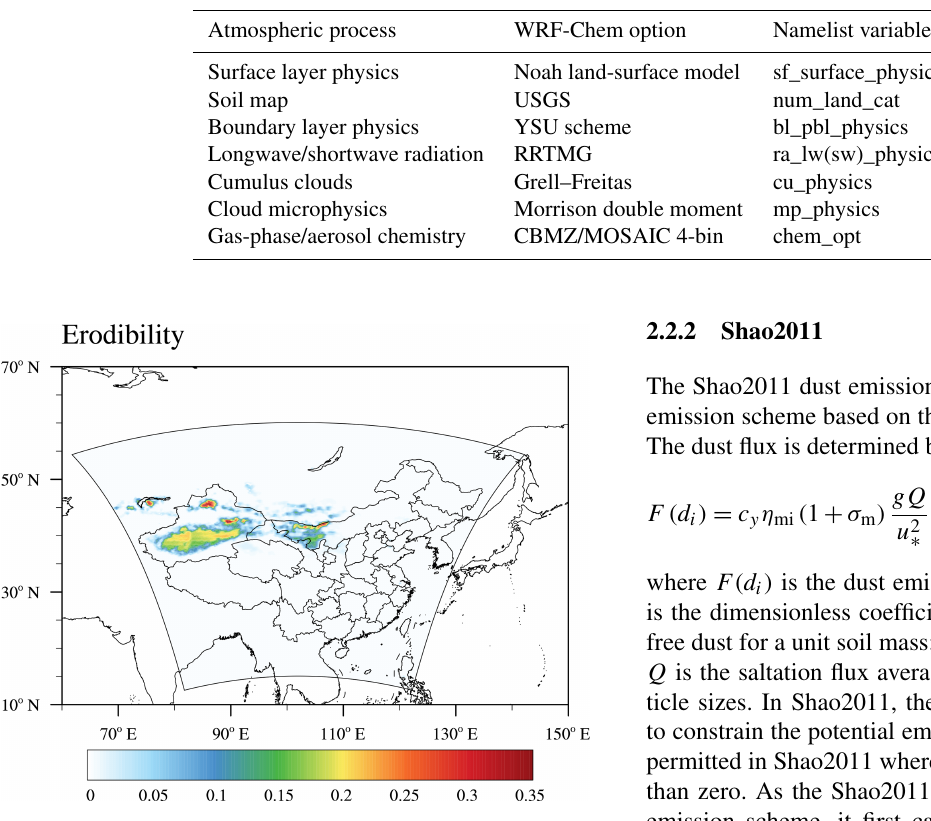
Figure 1. Domain map for the WRF-Chem simulations. The color shading shows the erodibility factor, which is the fraction of erodi- ble surface in each grid